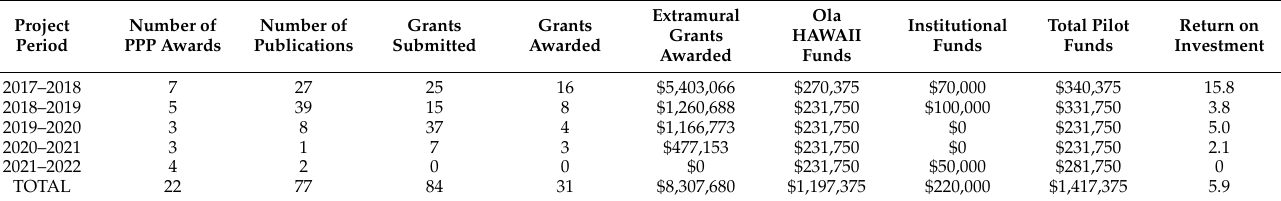
Table 2. Productivity of PPP